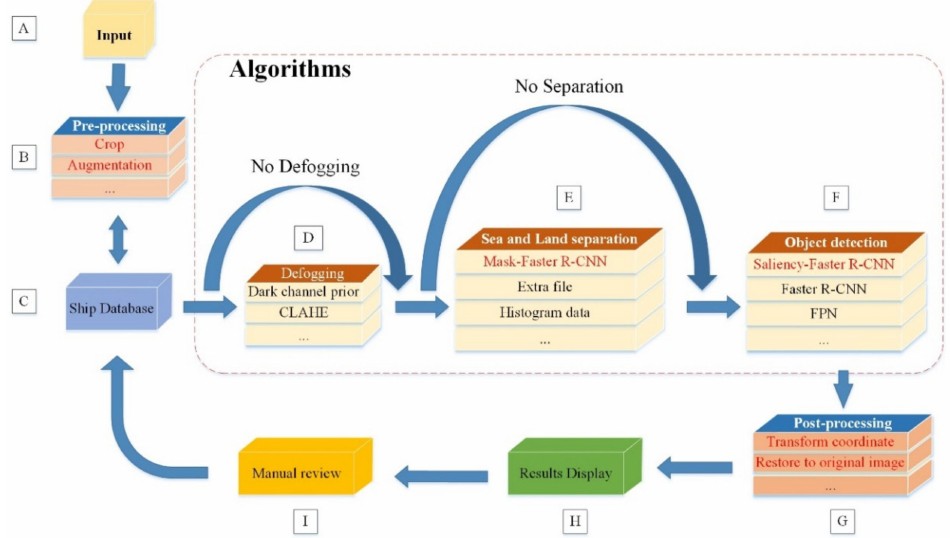
Figure 1. The framework of the broad area target search (BATS) system for the ship detection task.